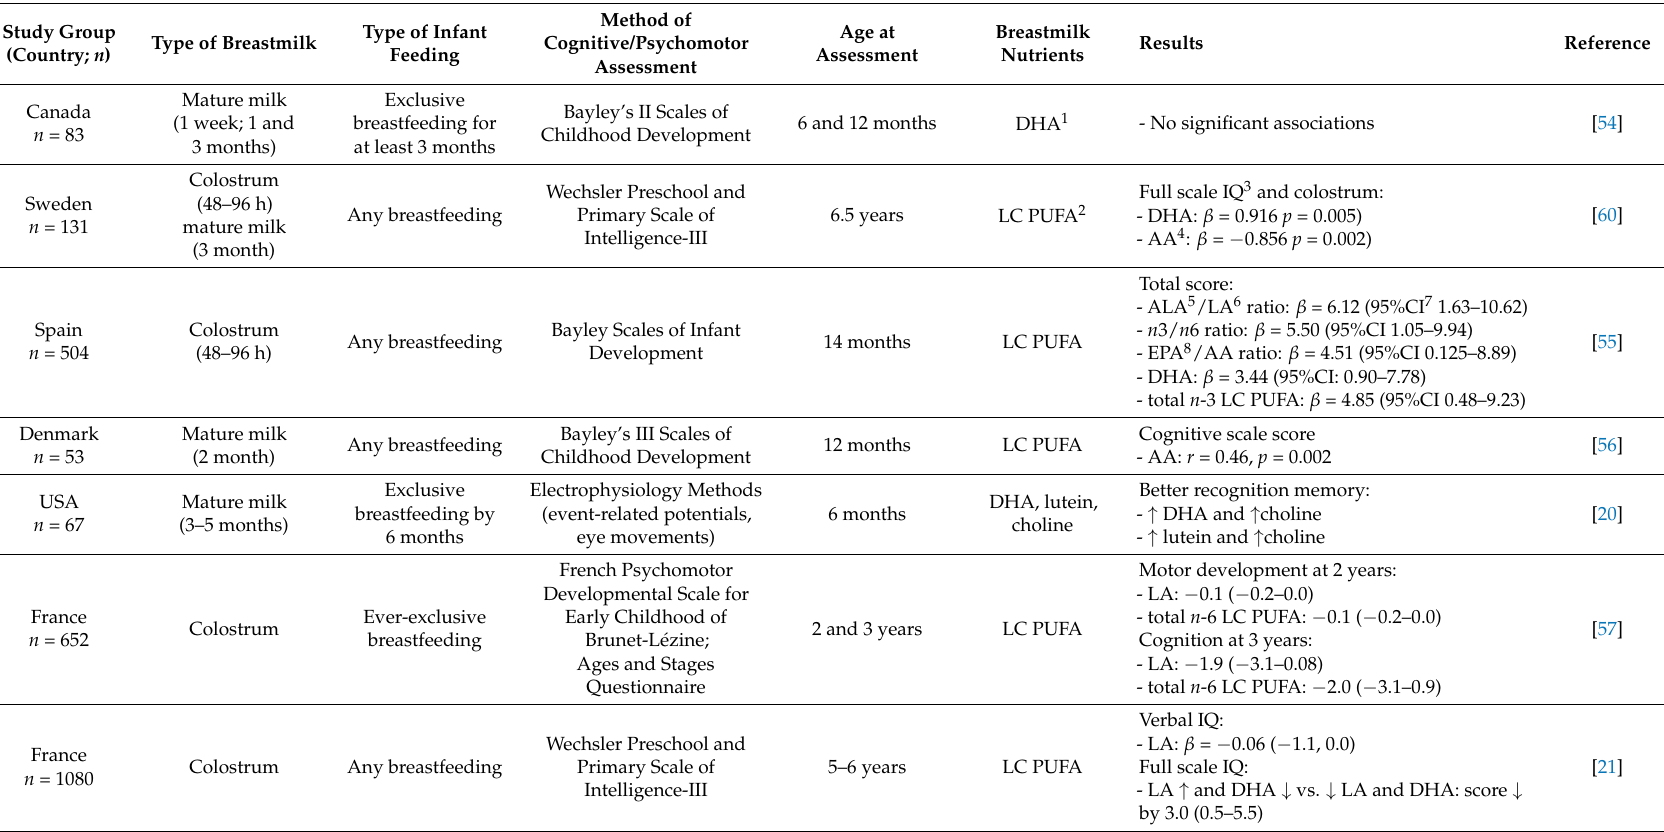
Table 6. The summarized results of studies on the associations between breastmilk fatty acids, carotenoids and child development. Study Group (Country; n